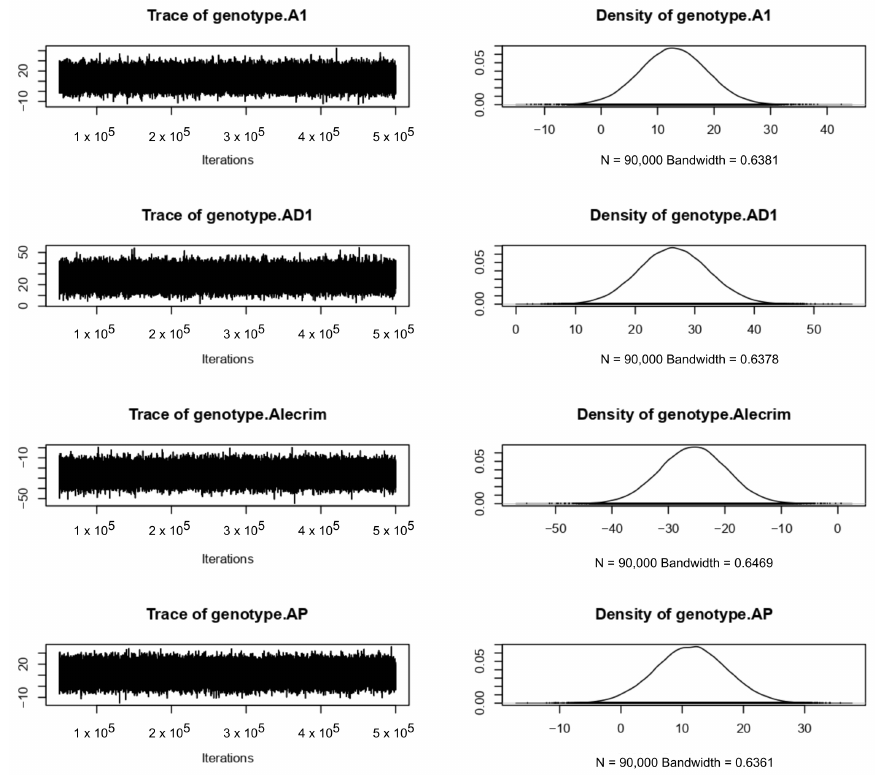
Figure A2. Time series of the chains and density curves of the effect of genotypes A1, AD1, Alecrim, and AP.